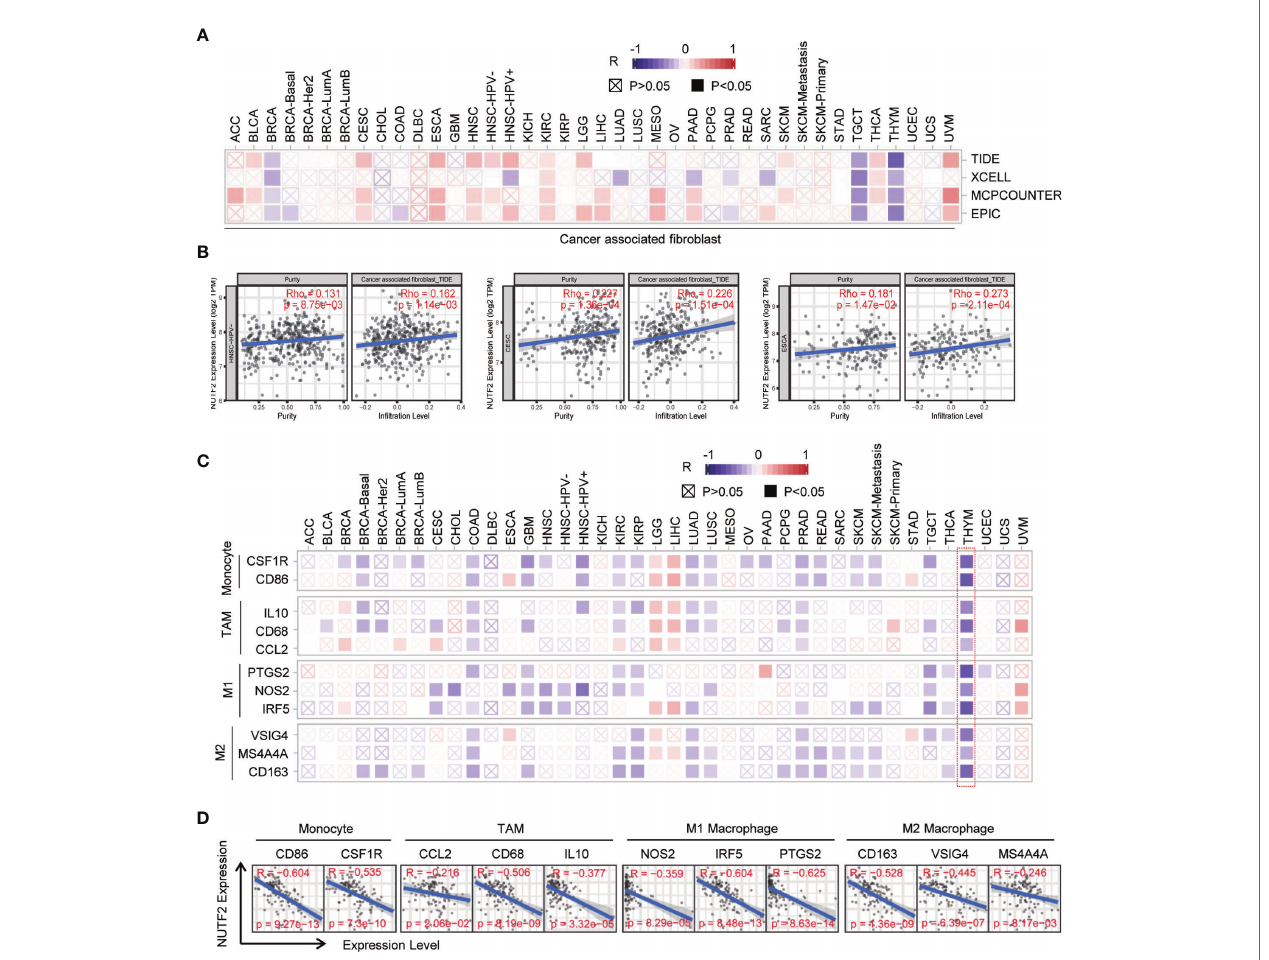
FIGURE 5 | Correlation analysis between NUTF2 expression and immune cell markers. (A) The potential association between NUTF2 expression level and CAF in fi ltration was explored by different algorithms. (B) The correlations between NUTF2 expression and in fi ltrated CAF in BRCA, THCA, and THYM were analyzed by EPIC or TIDE algorithm. (C) Correlation analysis between NUTF2 expression and immune marker genes across all types of cancers in TCGA. (D) The correlations between NUTF2 expression and marker genes of monocyte, TAMs, M1 Macrophage, and M2 Macrophage in